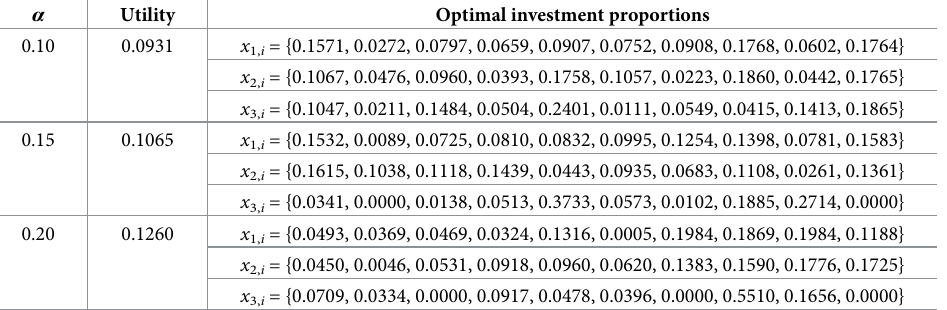
Table 3. Proportion of each security under different risk tolerance.